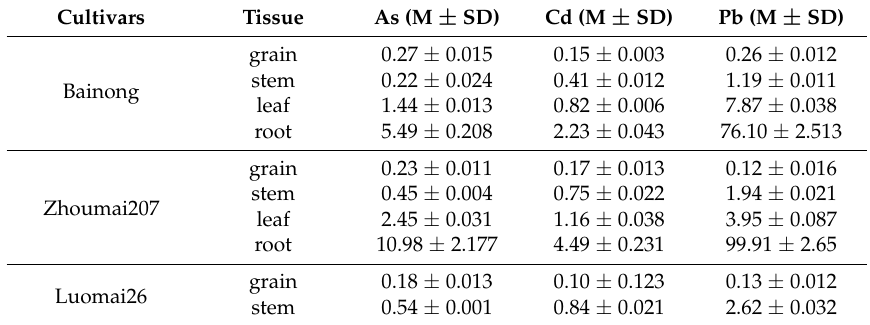
Table 2. As, Cd, and Pb concentrations in the grain, stem, leaf, and root of 16 wheat